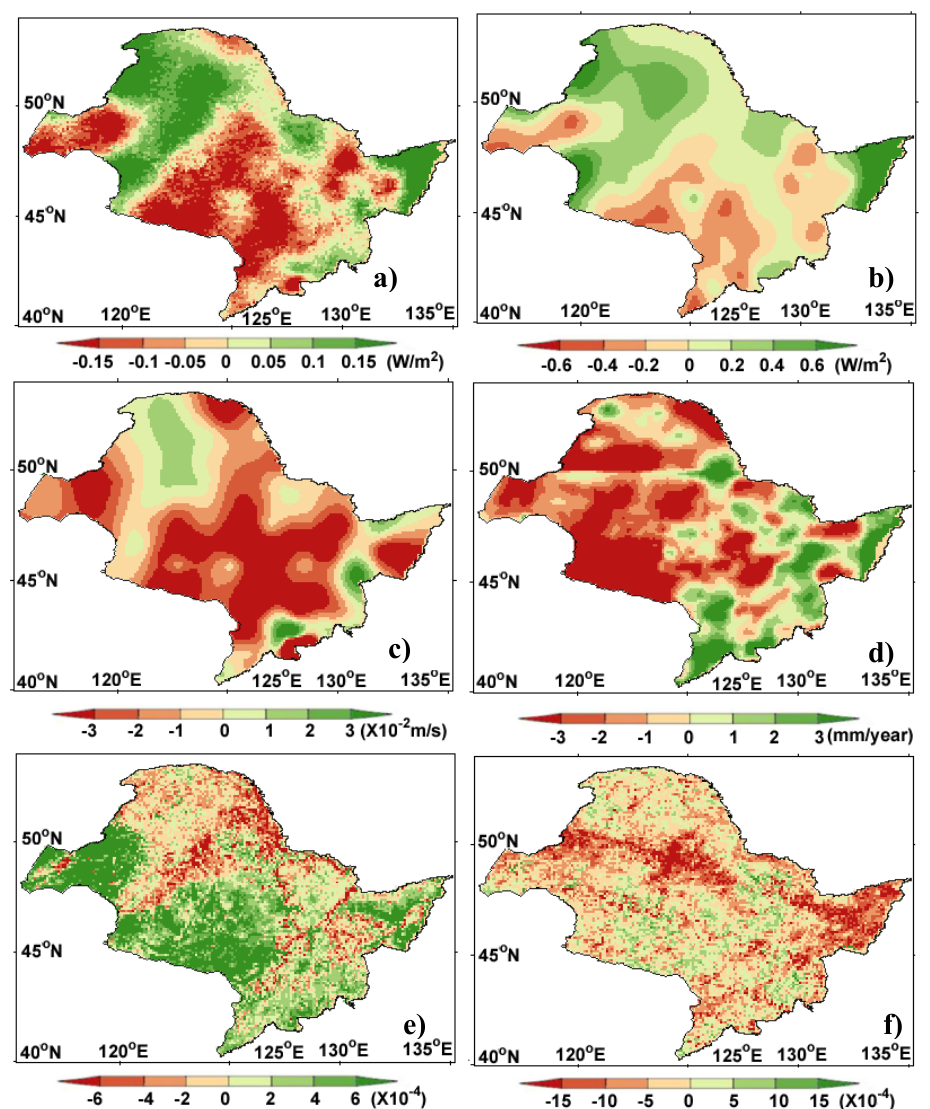
Figure 8. Spatial pattern of linear trends in annual ( a ) ET, ( b ) Rs, ( c ) WS, ( d ) P, ( e ) albedo and ( f ) NDVI between 1982 and